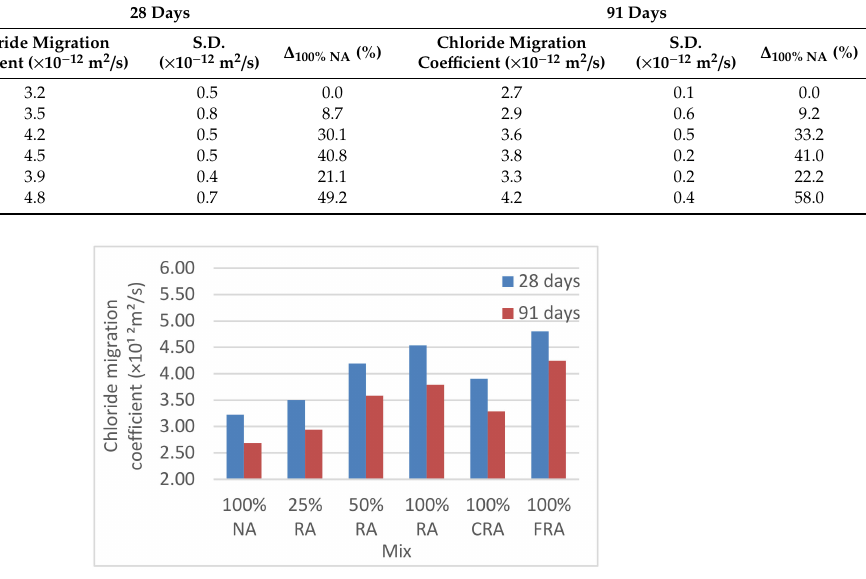
Table 8. Chloride migration results at 28 and 91 days.